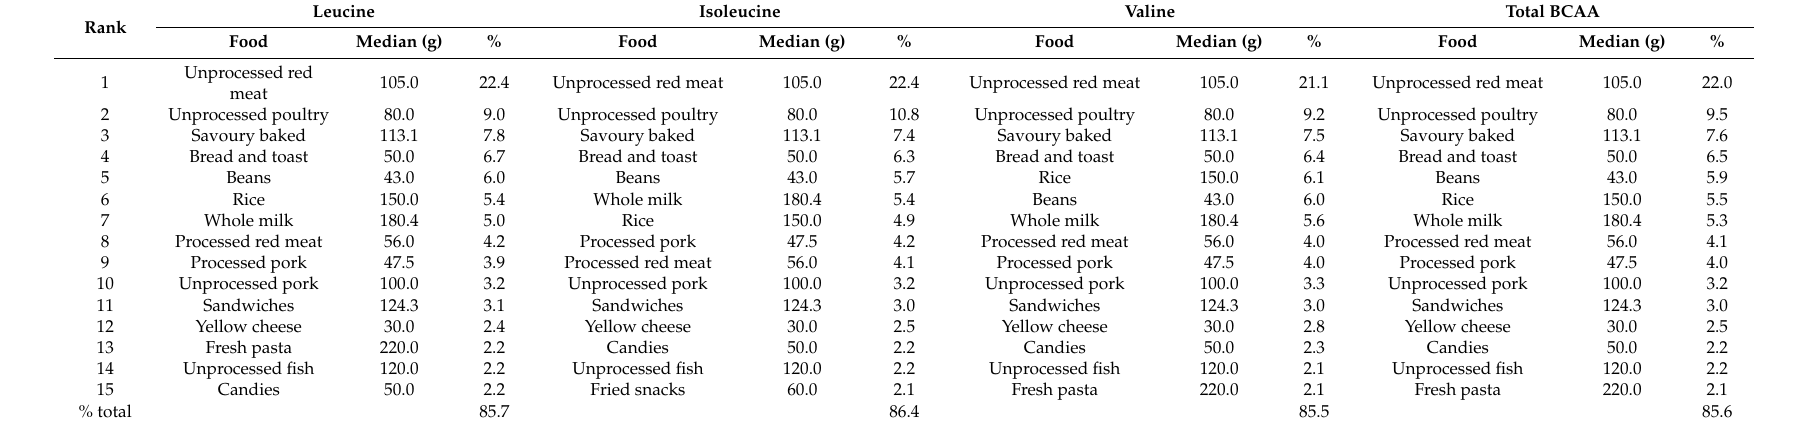
Table 4. Main food contributors to dietary intake of branched chain amino acids in adolescents, ISA Capital, S ã o Paulo, Brazil, 2008.